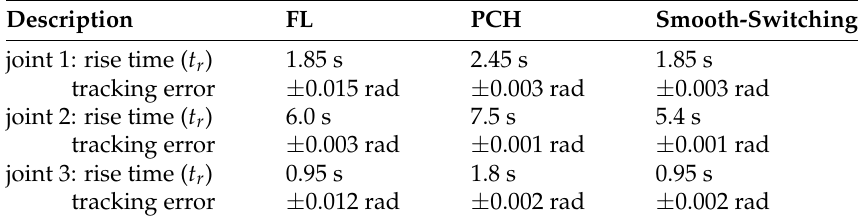
Figure 9. The trajectory tracking curve of the robot’s three joints with q d = 0.5 + 0.5sin ( 0.25 π t ) and σ = 0.01. Table 5. Performance indexes of FL, PCH and smooth-switching with q d = 1 + 0.5sin ( π t ) .